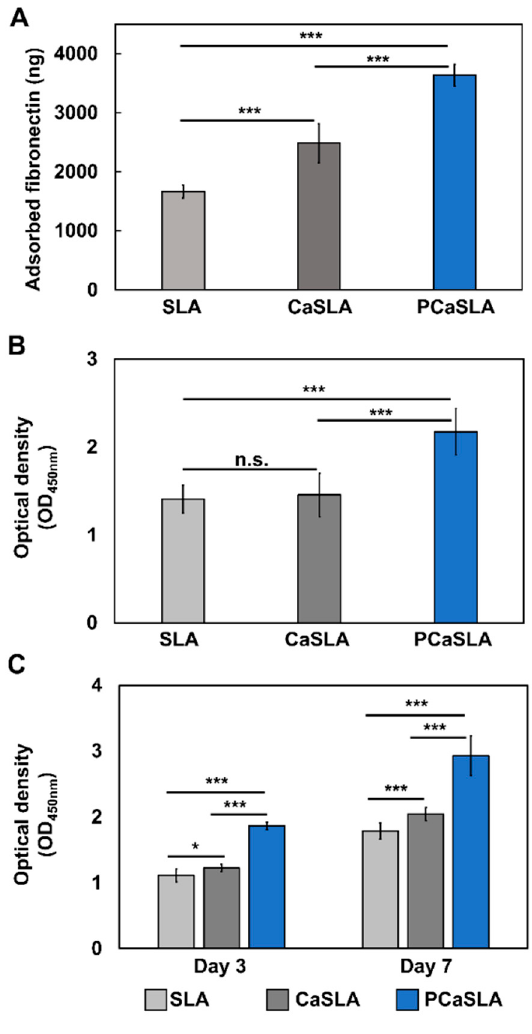
Figure 4. ( A ). the amount of adsorbed fibronectin, ( B ). the amount of adherent cells on SLA, CaSLA, and PCaSLA measured by CCK-8 assay after 2 h of culture, and ( C ). the amount of proliferated cells on SLA, CaSLA, and PCaSLA measured by CCK-8 assay at day 3 and day 7. [*, p < 0.05; ***, p < 0.001; n.s., not n.s., not significant].